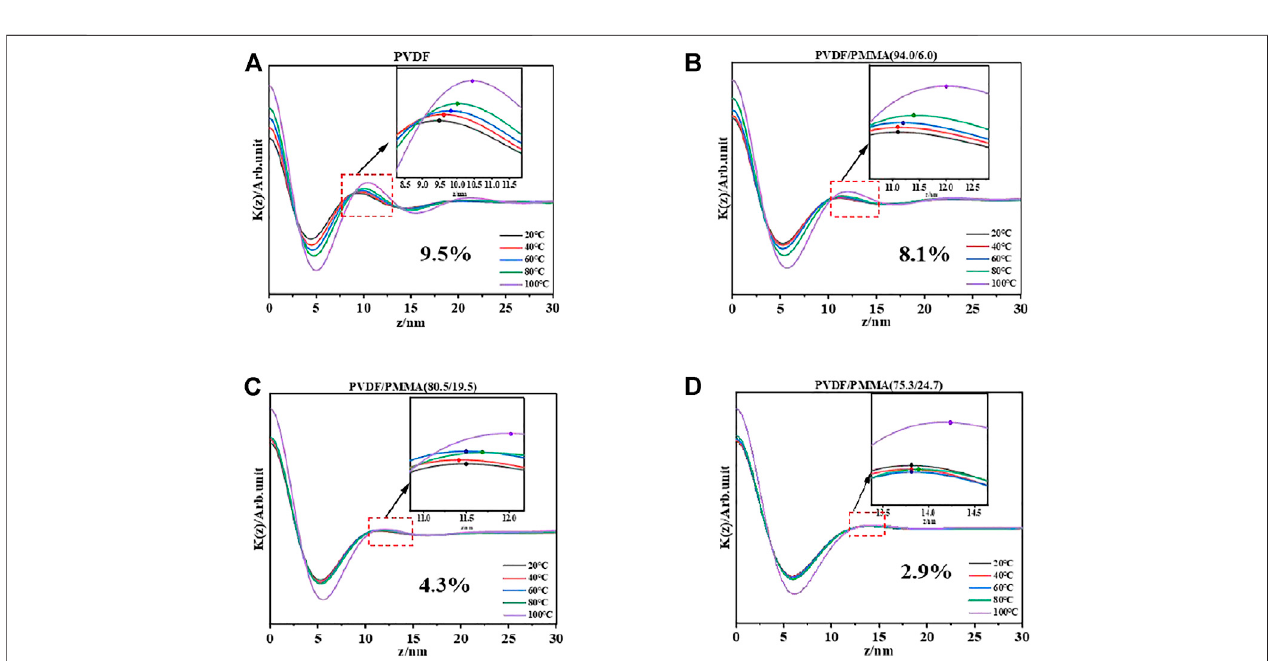
Frontiers in Chemistry |